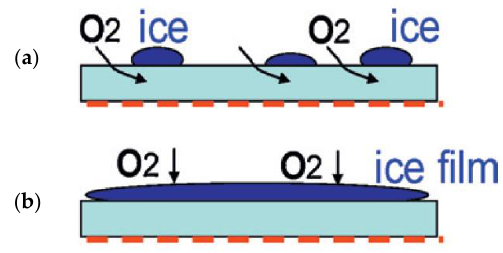
Figure 11. ( a ) Solid water islands scattered over the thin ionomer film, allowing oxygen access to the catalyst; ( b ) Ice islands connect, forming a thin ice layer and blocking oxygen access to the local catalyst. Reprinted from Wang et al. [20], with permission from Elsevier.